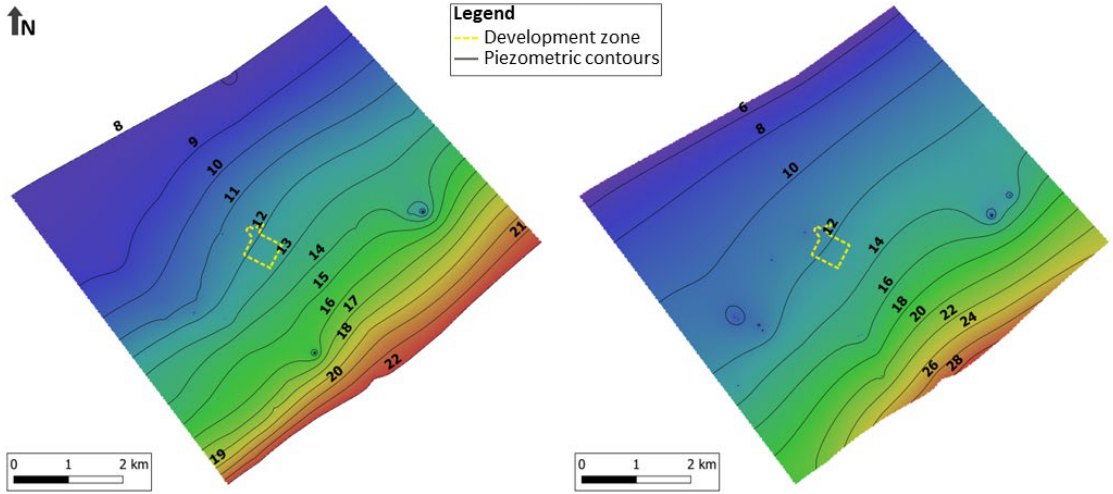
Figure 6. Calibrated potentiometric maps in the shallow aquifer ( left ) and in the fractured bedrock aquifer ( right ).